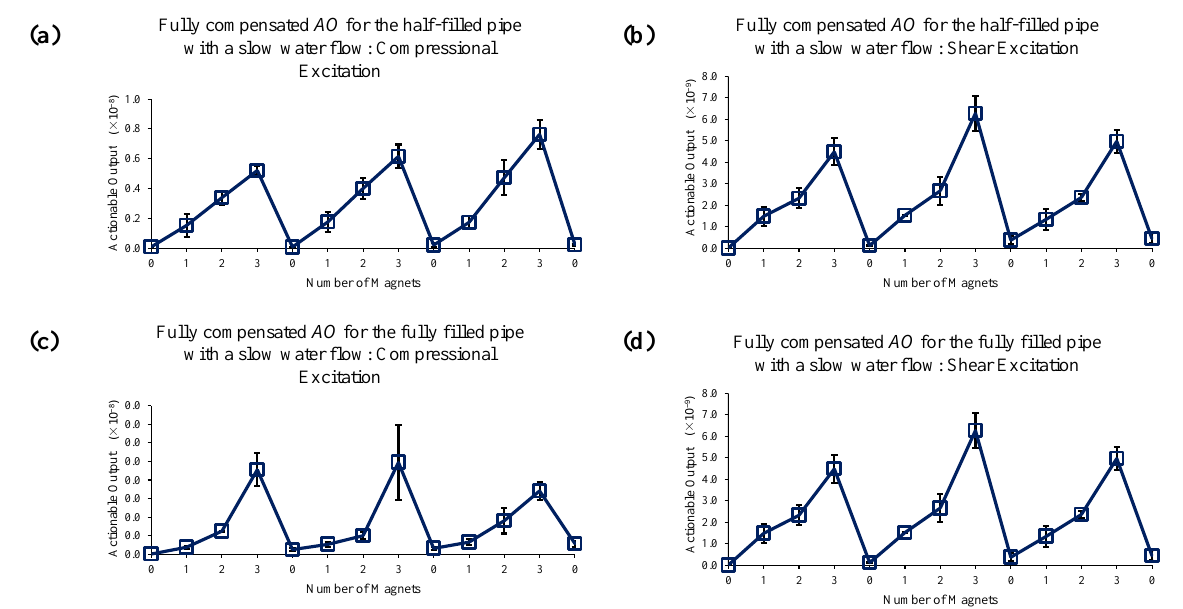
Figure 16. Changes in AO under slow water-flow conditions with the different number of magnet perturbations for the half-filled pipe with ( a ) compressional and ( b ) shear excitations; and the fully filled pipe with ( c ) compressional and ( d ) shear excitations. The full, two-level EOC compensation method is applied.